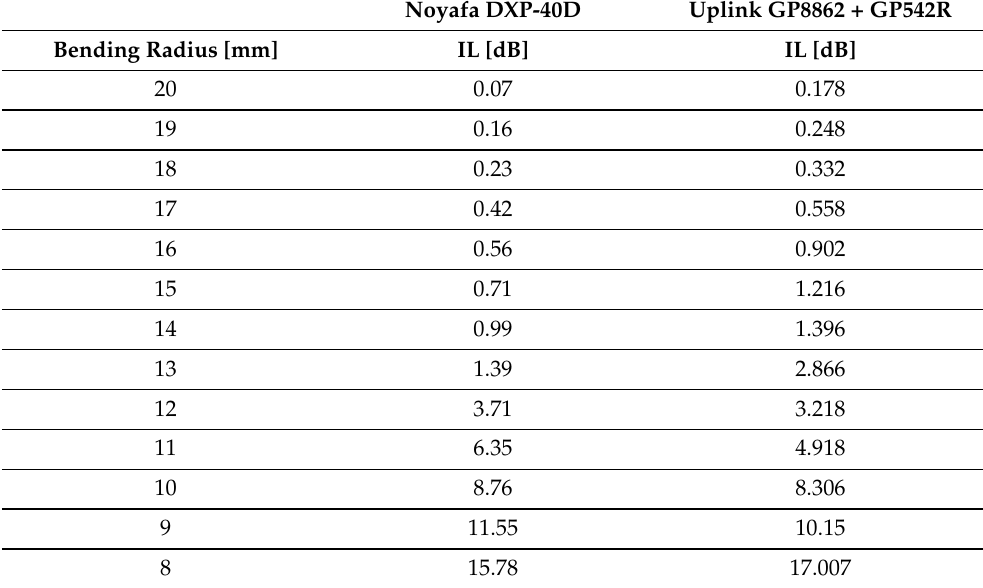
Table 7. Measured values of bending